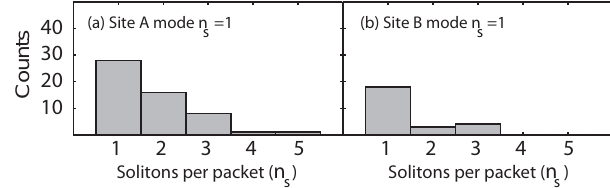
Figure 7. Distribution of number of solitary waves per packet ( n s ).